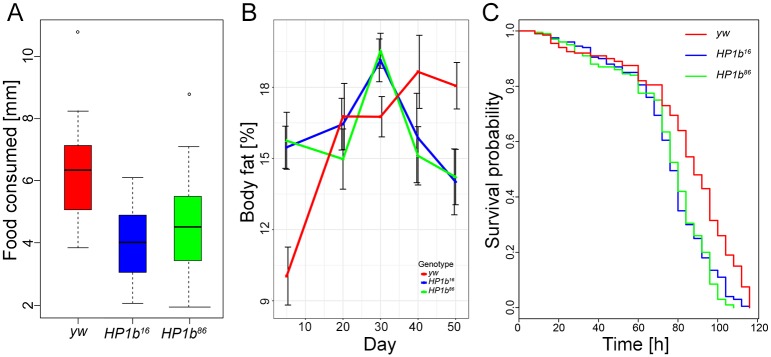
Loss of HP1B reduces food intake, alters body fat levels, and leads to oxidative stress resistance due to altered feeding behavior.A. Food intake measured using a CAFÉ assay (Y-axis, decrease in food levels over an 8hr time period as measured by drop in capillary meniscus in mm) reveals lower food intake in HP1b mutants (HP1b16: p = 0.0003155; HP1b86: p = 0.0095041; Tukey’s multiple comparisons of means; n = 8 per sex and genotype). Data from one representative trial, both sexes combined are shown. For results from the additional trials and separated by sex, see S1 Table. B. Percent body fat (Y-axis) was measured by QMR in animals of different ages (X-axis). Body fat levels are increased in mutant animals early in life but decrease at a rapid rate after midlife (30–40 days). Red: yw; blue: HP1b16; green: HP1b86. Error bars: SD. N = 4 per sex and genotype. C. After paraquat concentration is adjusted to take into account differences in feeding behavior between HP1b mutants (blue, green) and the yw control strain (red), HP1b mutants no longer exhibit increased resistance to oxidative stress. X-axis: Time to death in hours. Y-axis: Survival probability. For separate survival curves for males and females, see S5 Fig.